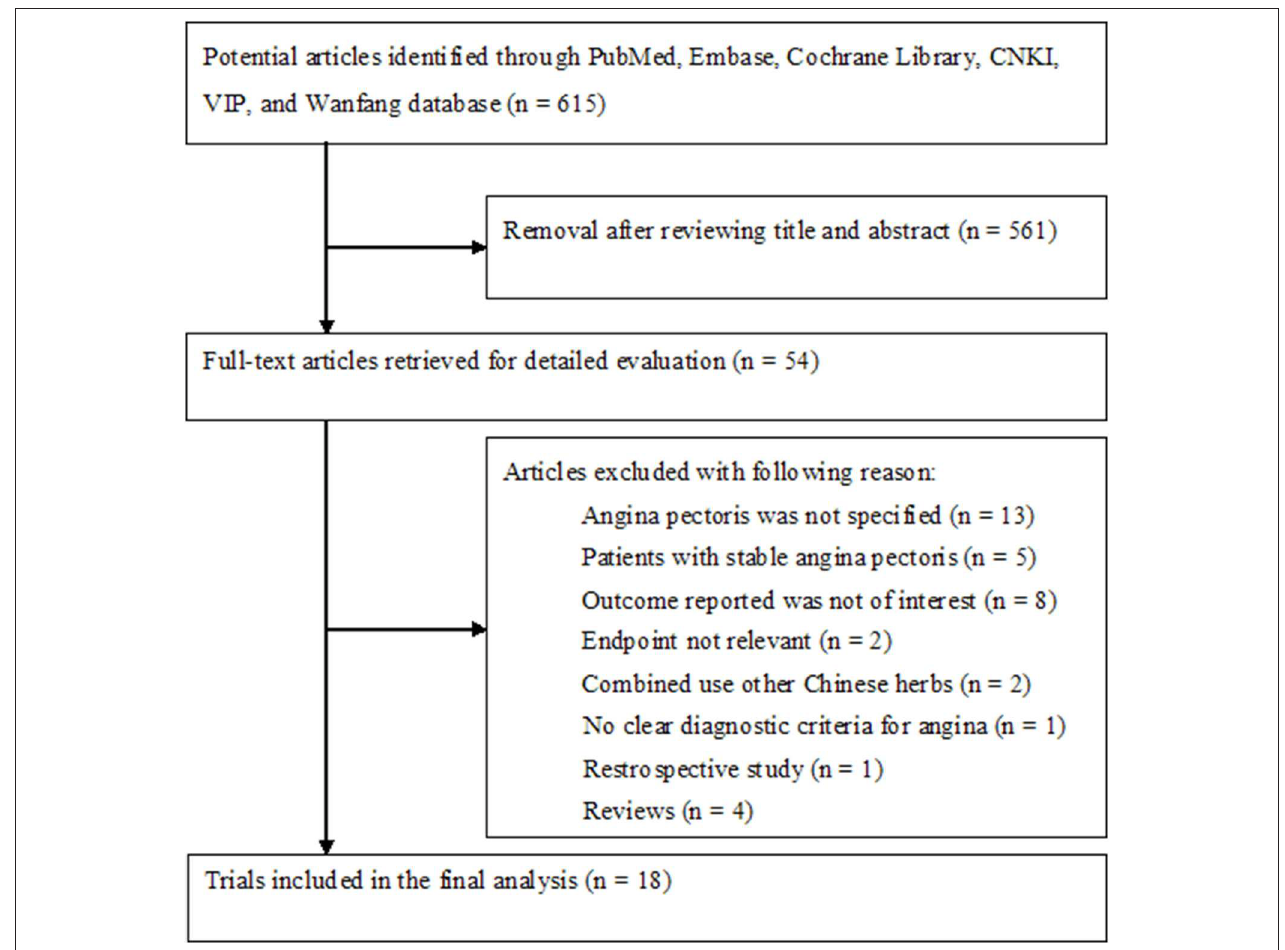
FIGURE 1 | Flow chart of studies selection